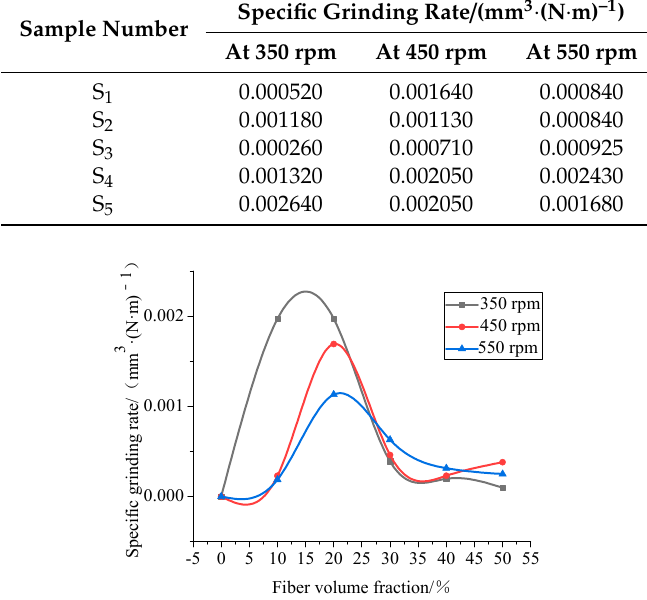
Figure 14. Influence of the palm kernel volume fraction on the wear rate of the type 1 composite material.